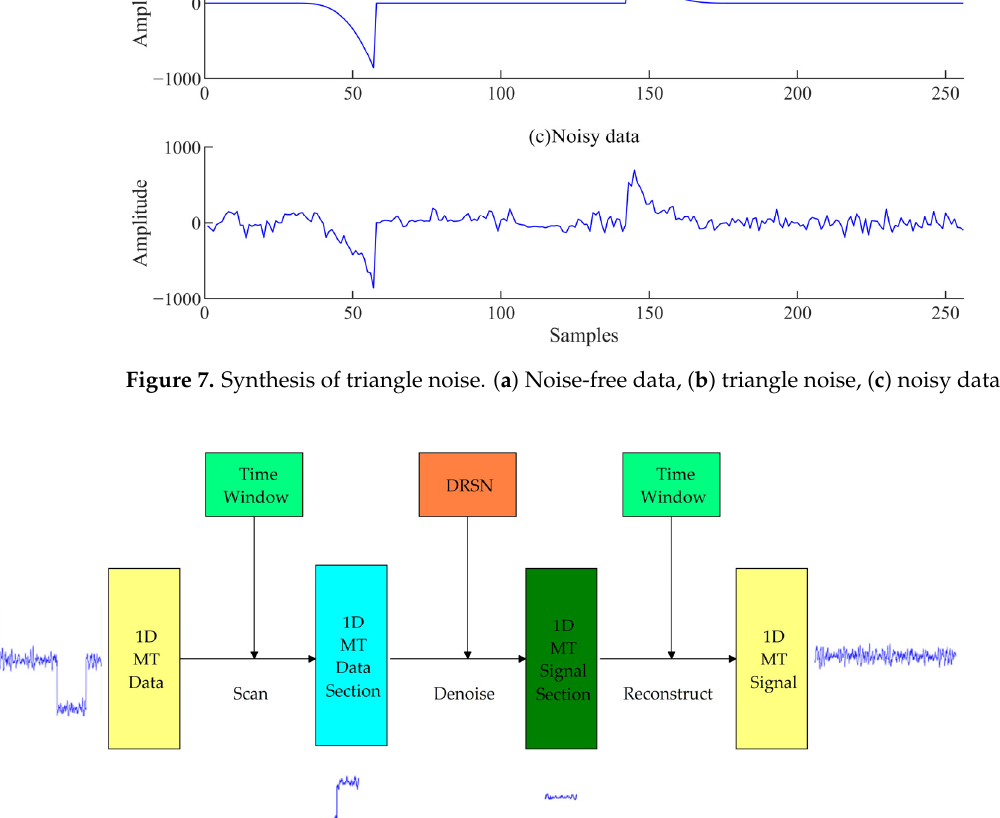
Figure 7. Synthesis of triangle noise. ( a ) Noise-free data, ( b ) triangle noise, ( c ) noisy data.